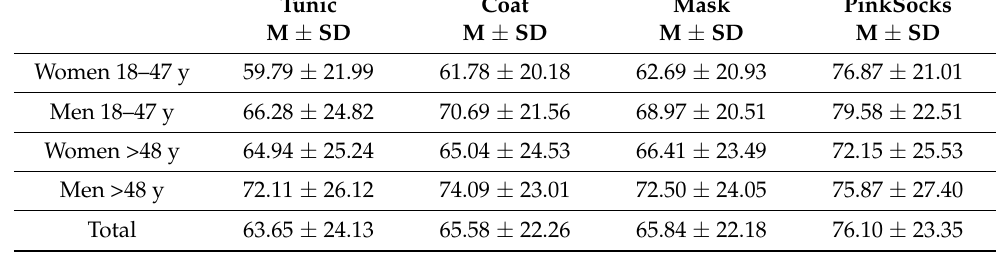
Table 1. Evaluation of the four photos according to sympathy (mean, standard deviation, n = 906).